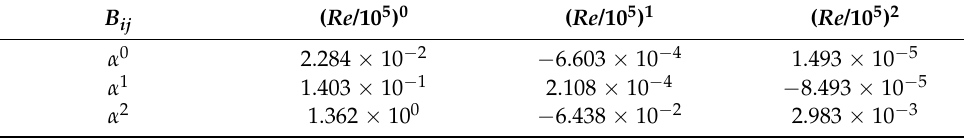
Table 2. Value of coefficient B ij .